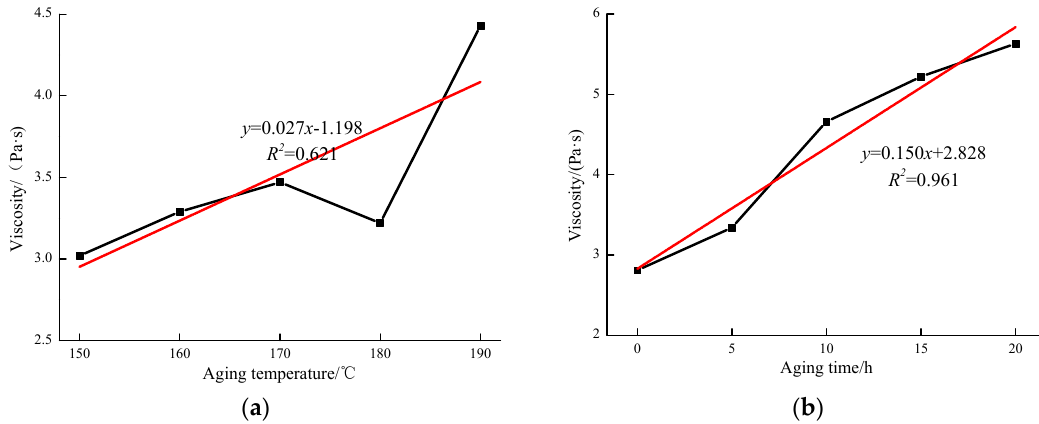
Figure 5. Viscosity values of MACRMA at different aging conditions: ( a ) aging temperature and ( b ) aging time.